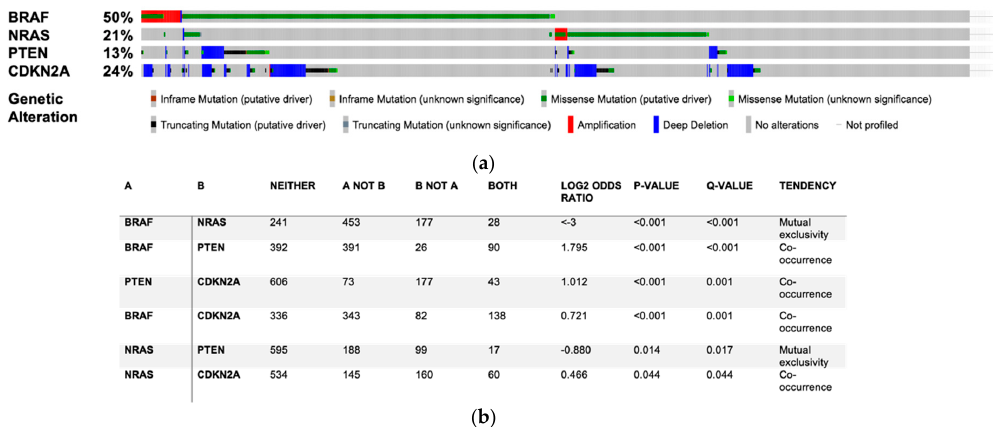
Figure 2. BRAF , NRAS , PTEN and CDKN2A are the most frequently mutated genes in cutaneous melanoma. Mutation rate, genetic alteration ( a ) and mutual exclusivity ( b ) for BRAF , NRAS , PTEN and CDKN2A mutations observed in 1635 samples from 1584 patients included in 12 studies analysed on cBioportal for cancer genomics (https: //